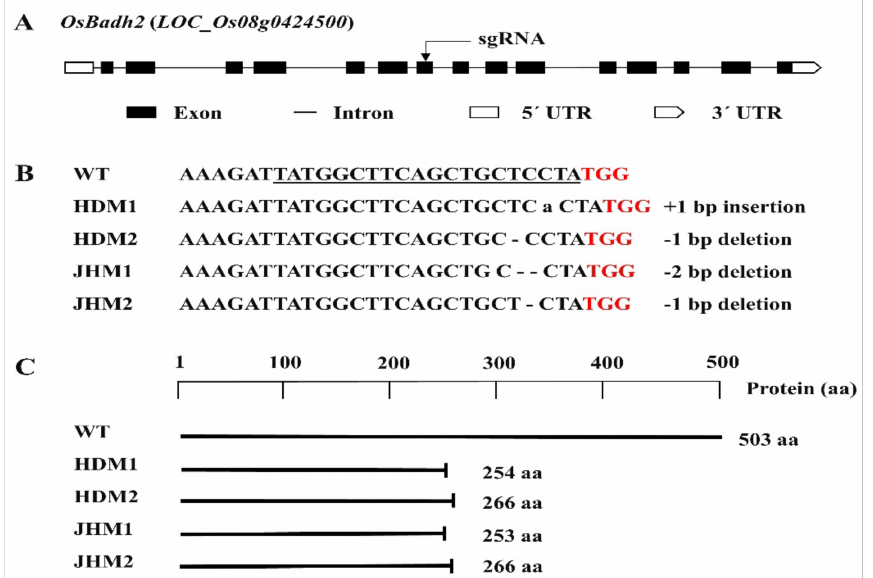
Figure 1. Details of the OsBadh2 gene-targeted mutagenesis using the CRISPR-Cas9 system: ( A ) diagram of the OsBadh2 gene’s structure with the target region, exon, intron, and UTRs; ( B ) DNA sequences of the target region with PAM (red), sgRNA (underline), and 1-2 bp inser- tion or deletion; ( C ) schematic presentation of the protein and truncation in protein translation in the wild type and